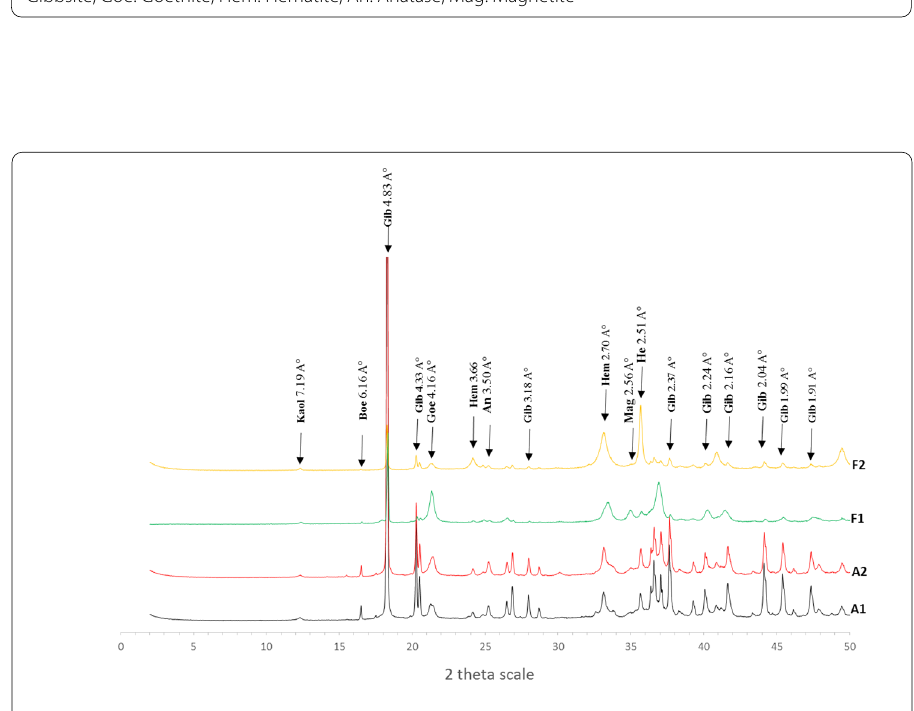
Fig. 7 XRD patterns of laterite